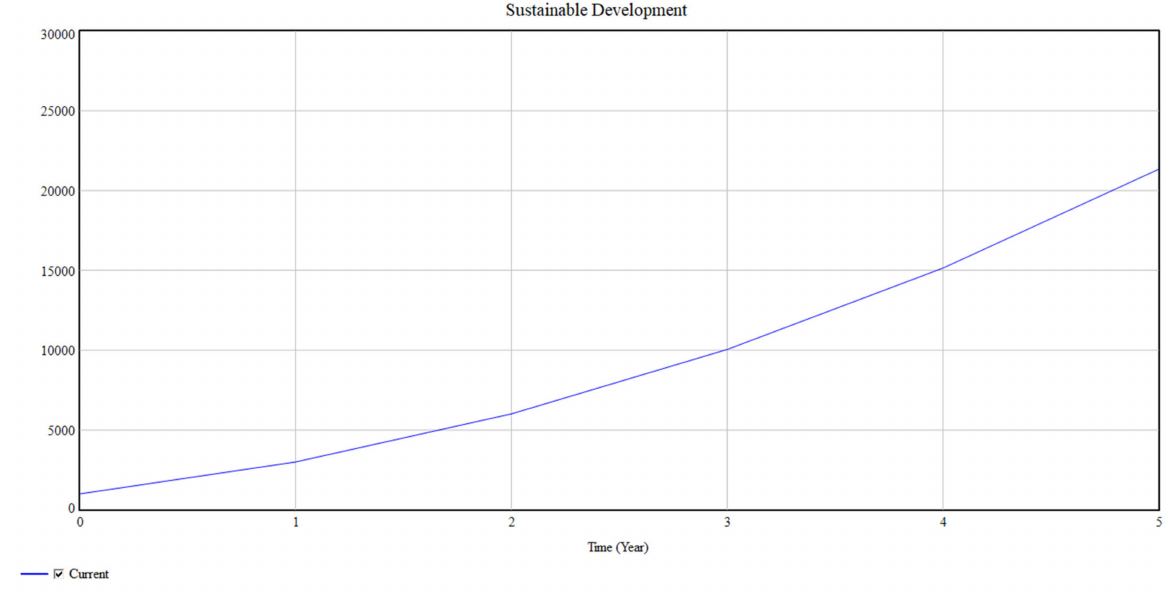
Figure 14. Simulation graph for Sustainable